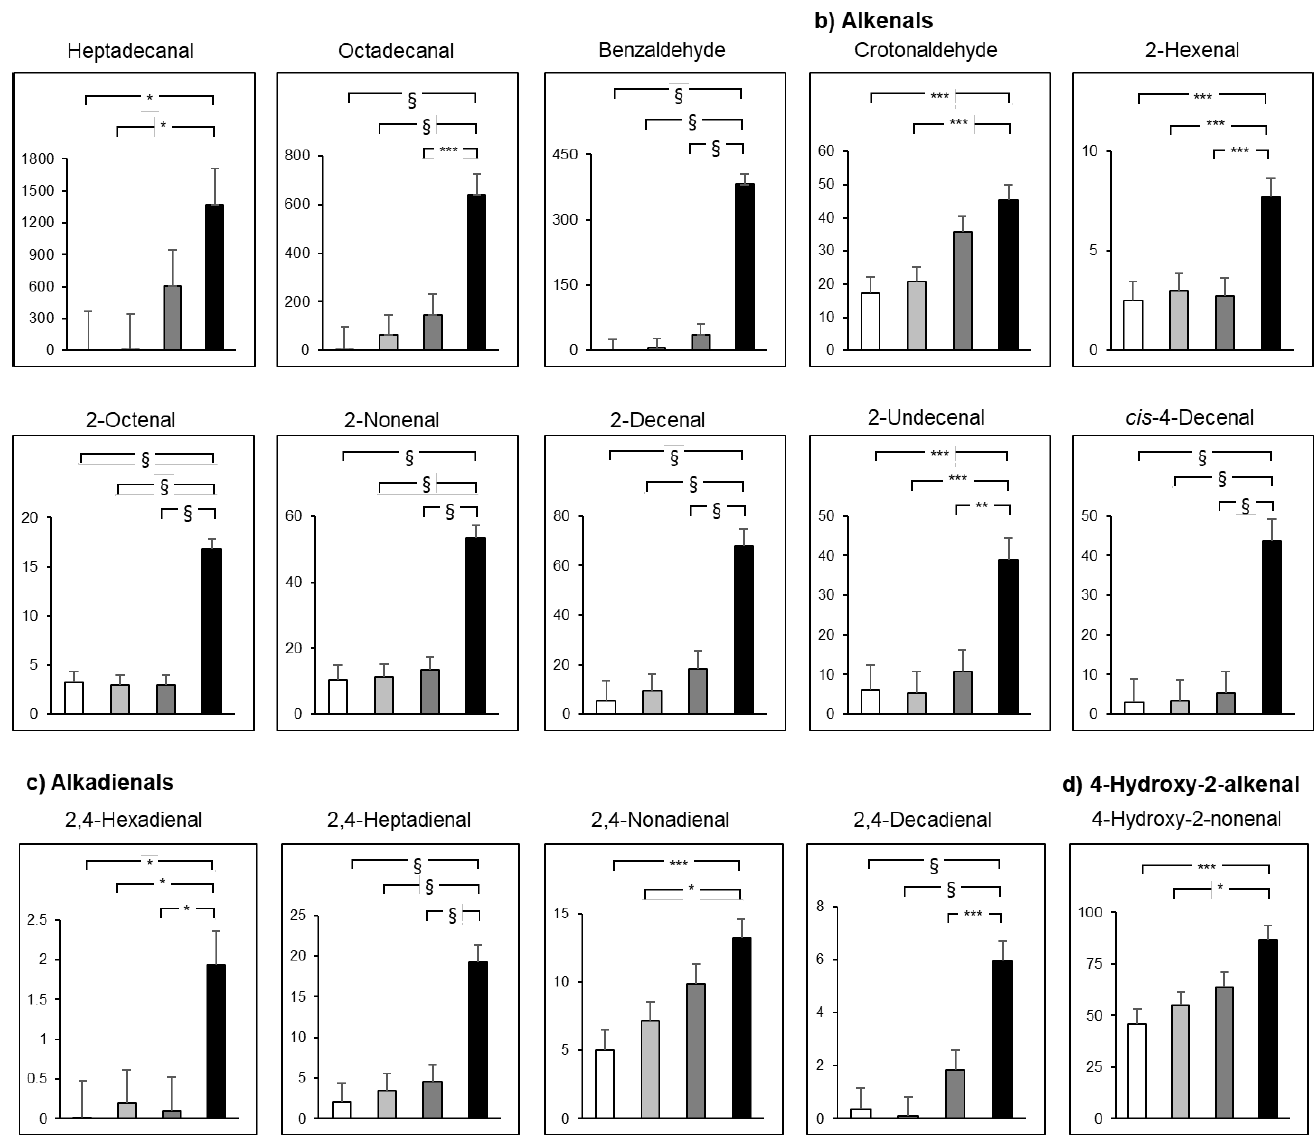
Figure 4. The levels (pmol/mL) of each reactive carbonyl species (RCS) were compared among each group ( a – d ). Open bars indicate RCS in the no-smoking and no-drinking group. Light gray bars indicate RCS in the no-smoking and drinking group. Dark gray bars indicate RCS in the smoking and no-drinking group. Solid bars indicate RCS in the smoking and alcohol-drinking group. Differences were analyzed by 1-way analysis covariance (ANCOVA) with post hoc Tukey analysis. The estimated means and errors are shown for each group. *: p < 0.05. **: p < 0.01, ***: p < 0.005, §: p < 0.001.